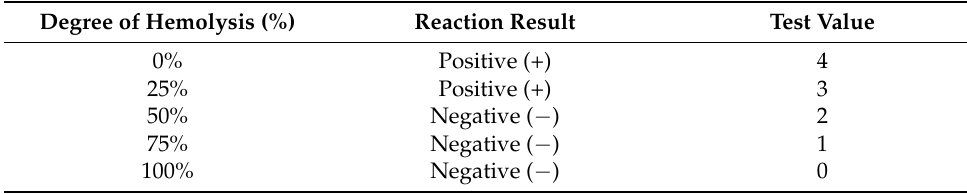
Table 1. Reference values for complement fixation test